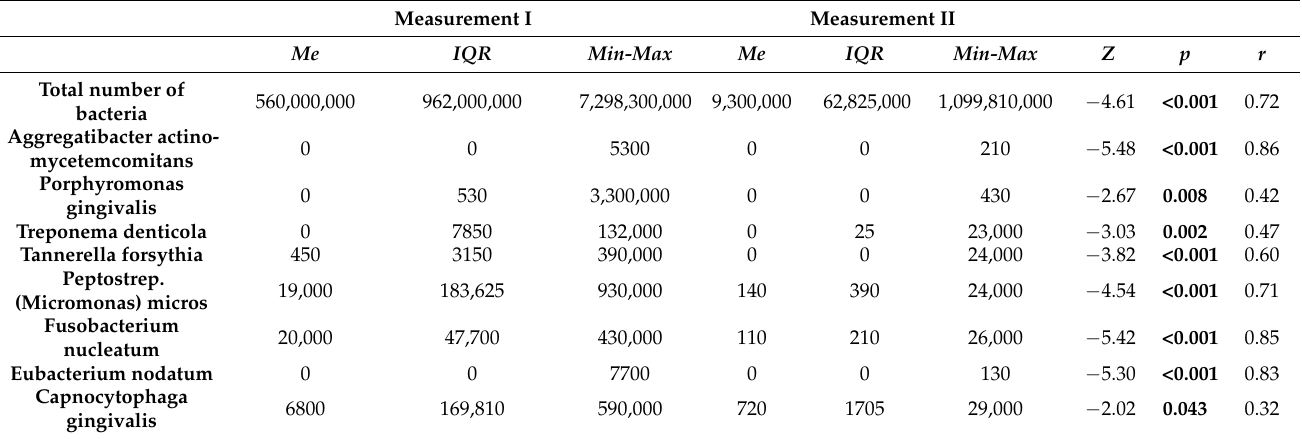
Table 5. Number of bacteria per strain in implants gingival pockets of patients before (measurement I) and after treatment (measurement II) with a bioactive healing abutment containing clindamycin.